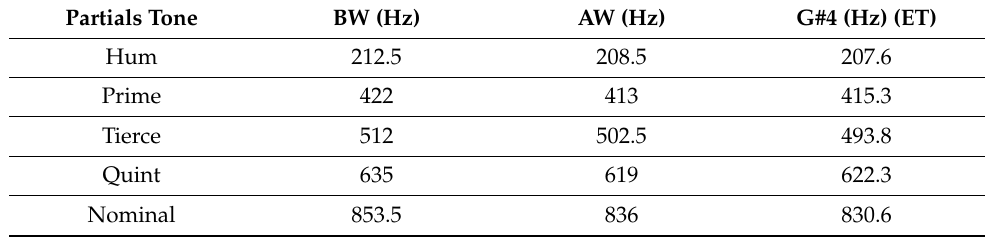
Table 3. Main partials of the St. Maryan bell’s sound frequencies before and after welding in com- parison to harmonic tones for the musical note G#4.